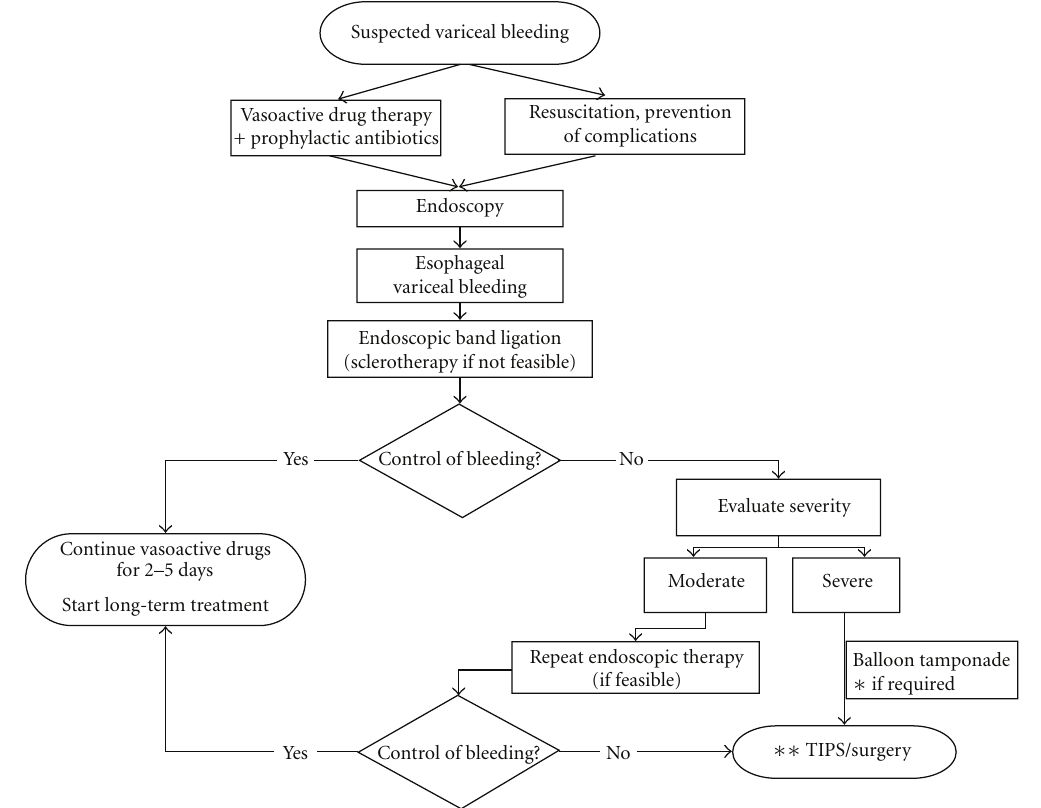
Figure 1: Algorithm of the current management of acute bleeding from ruptured esophageal varices. ∗ Self-expandable esophageal metallic stent may represent an alternative to balloon tamponade in this situation. ∗∗ Preferably TIPS with PTFE-covered stents (from reference [2], with